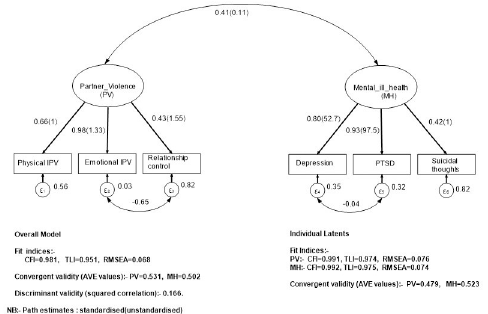
Fig 1. Latent convergent and discriminant validity model (female students survey: South African Technical Vocational Education and Training (TVET) colleges and universities (2018–2019).